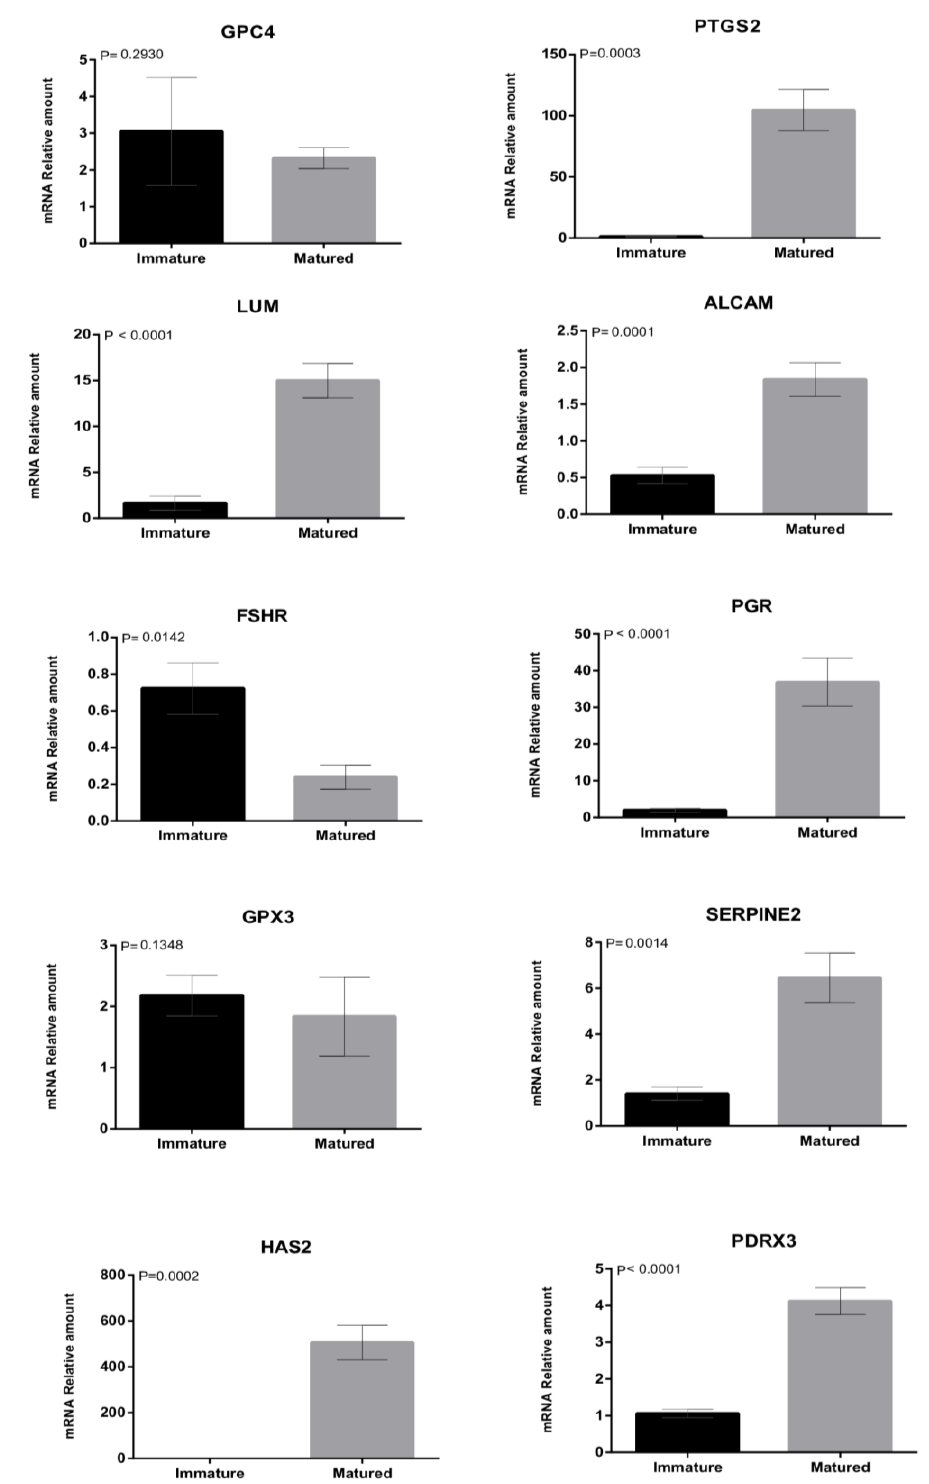
Figure 1. Relative abundance of messenger RNA (mRNA) encoding GPC4, PTGS2, LUM, ALCAM, FSHR, PGR, GPX3, SERPINE2, HAS2, and PRDX3 genes determined by quantitative polymerase chain reaction in immature (black bar) or CCs of COCs undergoing maturation (gray bar). Mean ± standard error of the mean (SEM) of three biological replicates. The data were normalized using the formula DDCT by Pfaffl [46], with GAPDH as an endogenous control. The differences were significant when p < 0.05, according to the T test.